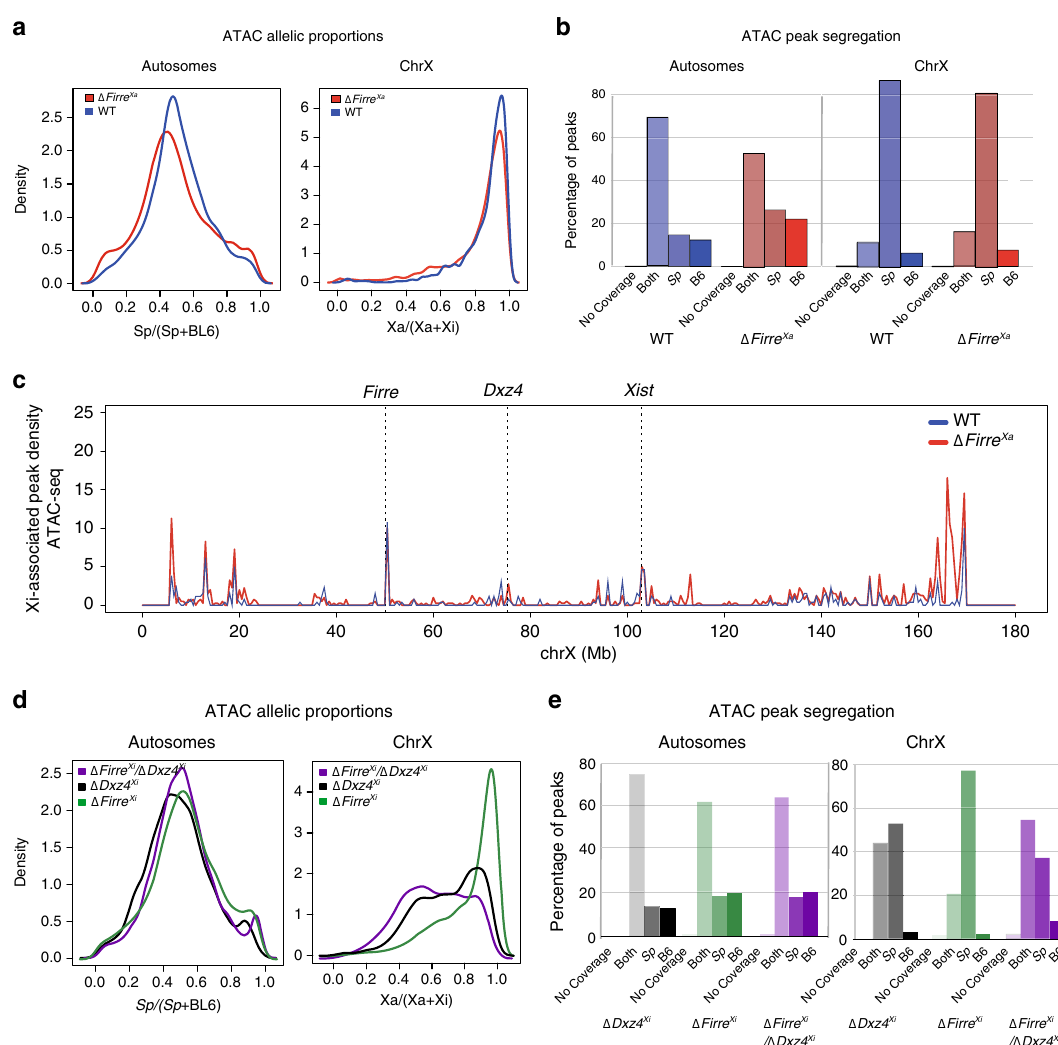
Fig. 7 Chromatin accessibility after allelic Firre deletions and a Firre/Dxz4 deletion. a Density histograms of the distribution of allelic proportions ( spretus /( spretus + BL6)) of ATAC peaks along the autosomes and the X chromosomes for WT (blue) and Δ Firre Xa (red). No shift is observed (Wilcoxon test: − log10P = 32). b . Percentages of ATAC peaks along the autosomes and the X chromosomes classi fi ed as spretus -speci fi c, BL6-speci fi c, or both show no differences between WT (blue) and Δ Firre Xa (red). c . Plots of Xi-associated (common + Xi-speci fi c) ATAC peak density (counts binned within 500 kb windows) along the Xi show increased accessibility at the telomeric end of the Xi in Δ Firre Xa (red) versus WT (blue). To account for differences in the number of SNP-covered peaks between samples due to sequencing depth, the binned counts are scaled by a factor obtained from the between-sample ratios of autosomal diploid SNP-covered peaks. d Density histograms of the distribution of allelic proportions ( spretus /( spretus + BL6)) of ATAC peaks show a shift to a lower Xa/(Xa + Xi) ratio in the double-mutant Δ Firre Xi / Δ Dxz4 Xi (purple), compared to Δ Dxz4 Xi (black) and Δ Firre Xi (green), consistent with increased accessibility on the Xi (Wilcoxon test: − log10P = 35). e Percentages of ATAC peaks in Δ Dxz4 Xi (black), Δ Firre Xi (green), and Δ Firre Xi / Δ Dxz4 Xi (purple) along the autosomes and the X chromosomes classi fi ed as spretus -speci fi c, BL6-speci fi c, or both show an increase on the BL6 Xi in the double